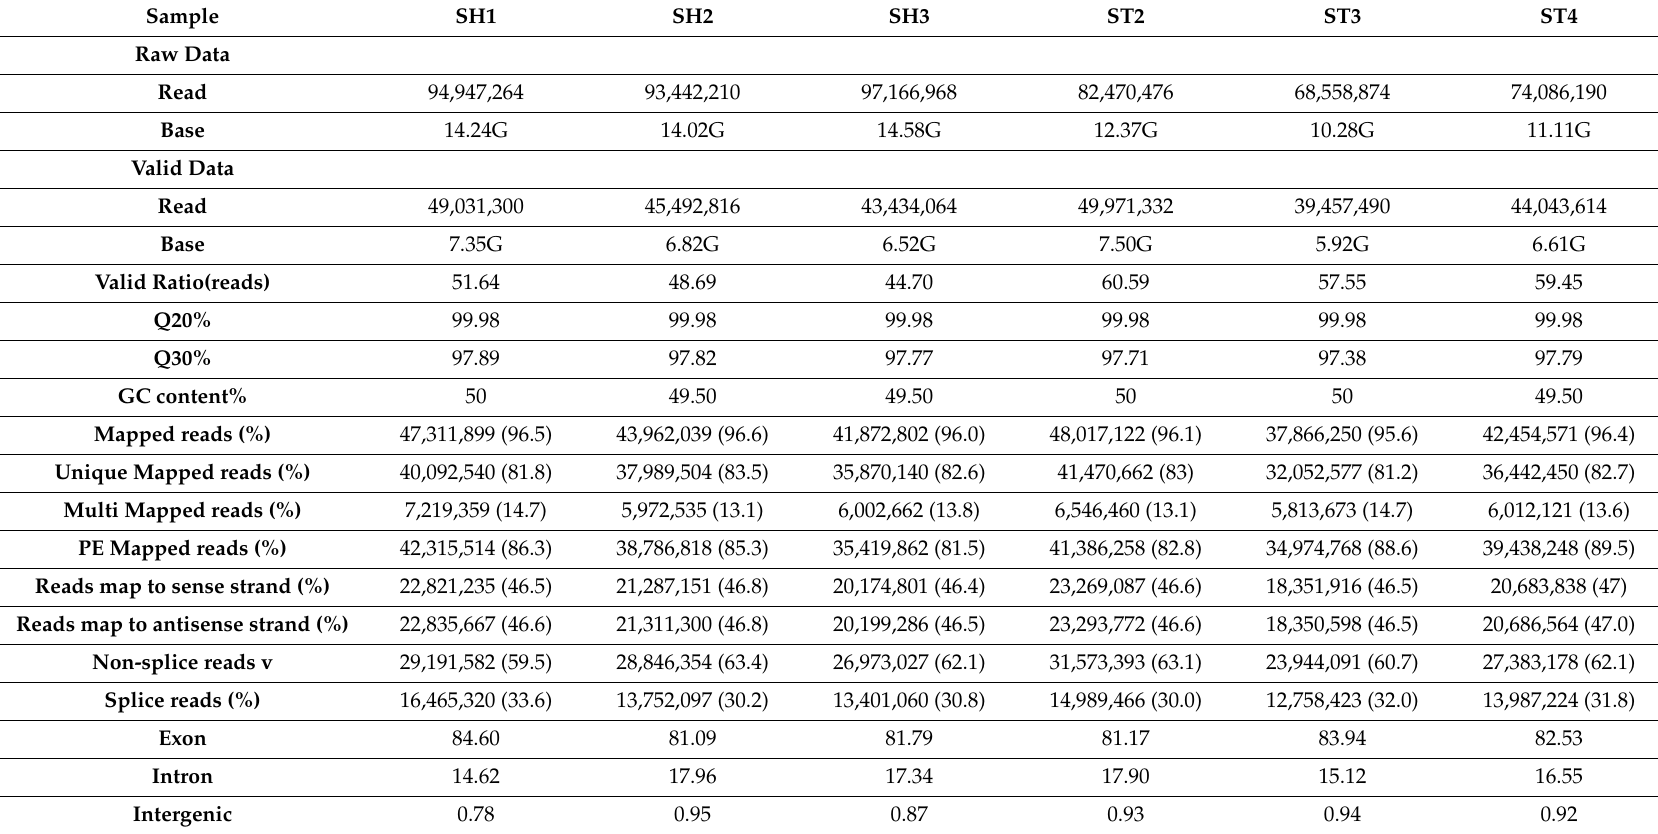
Table 1. Summary of the transcriptome sequencing between the skeletal muscles of sham and stroke